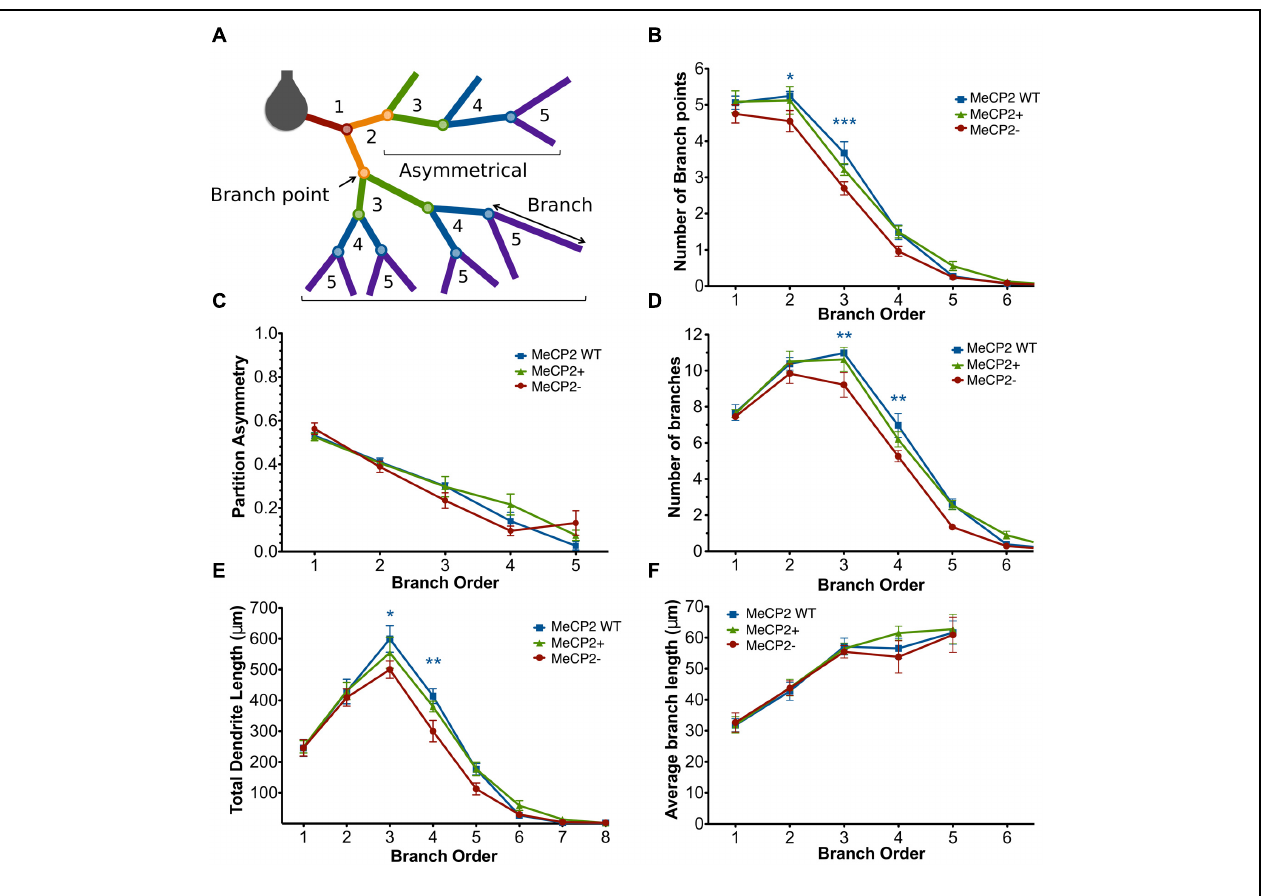
FIGURE 6 | MeCP2 − neurons have fewer third and fourth order branches compared to both other genotypes. (A) Branch order diagram depicting the increasing order values with each successive branch point from the cell body. Symmetrical and asymmetrical branching patterns are shown (calculated at the second order branch points) which result in partition asymmetry values of 0 and 1, respectively. (B) MeCP2 − neurons have fewer